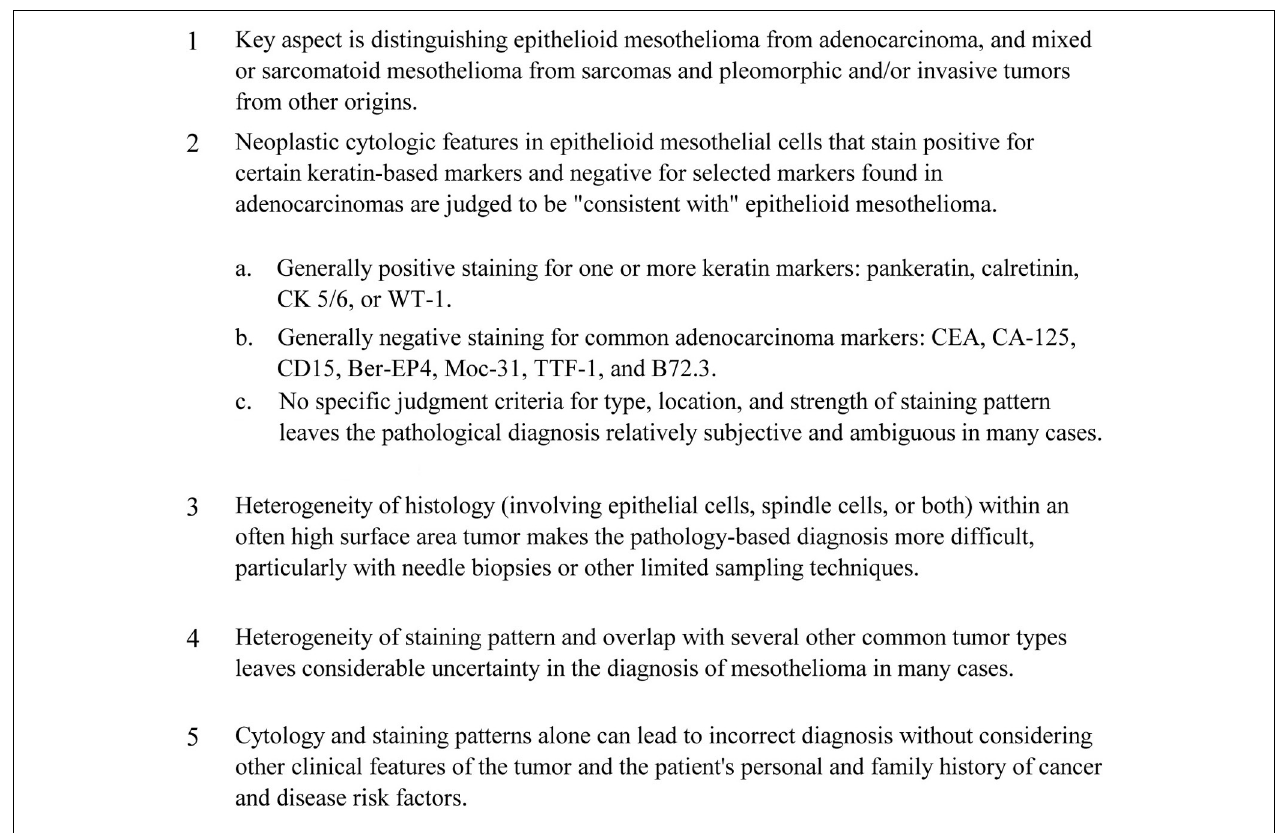
FIGURE 1 | Difficulties with diagnosis of primary mesothelioma using only cytology and immunohistochemical staining